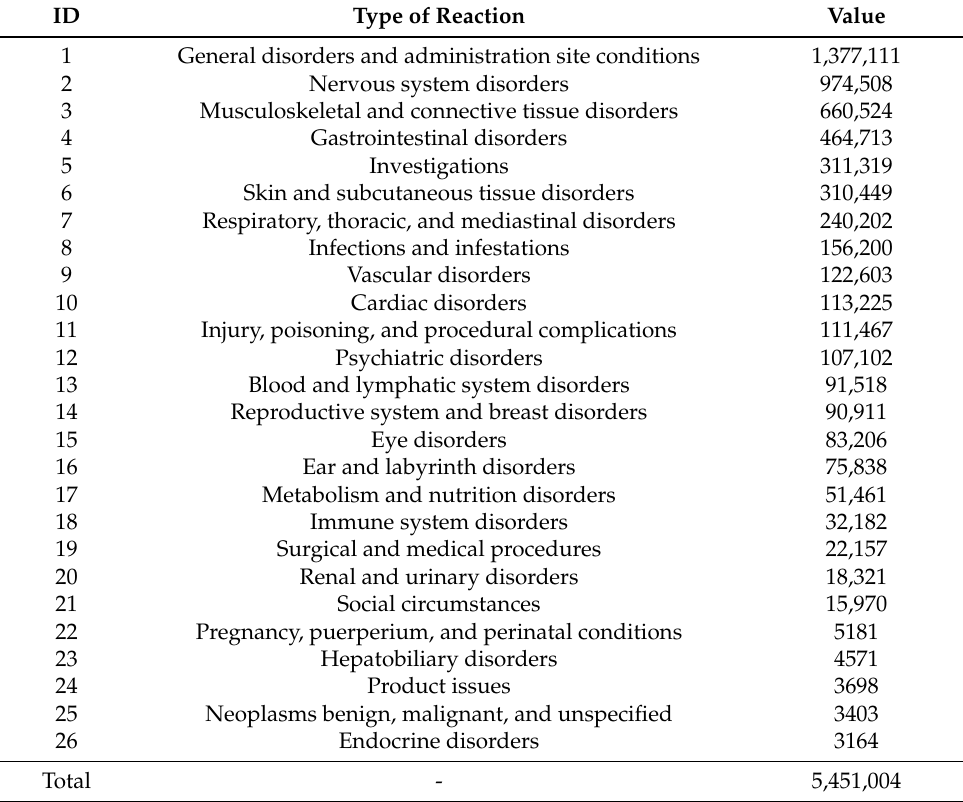
Table 1. Distribution of adverse events by System Organ Class (SOC) for all COVID-19